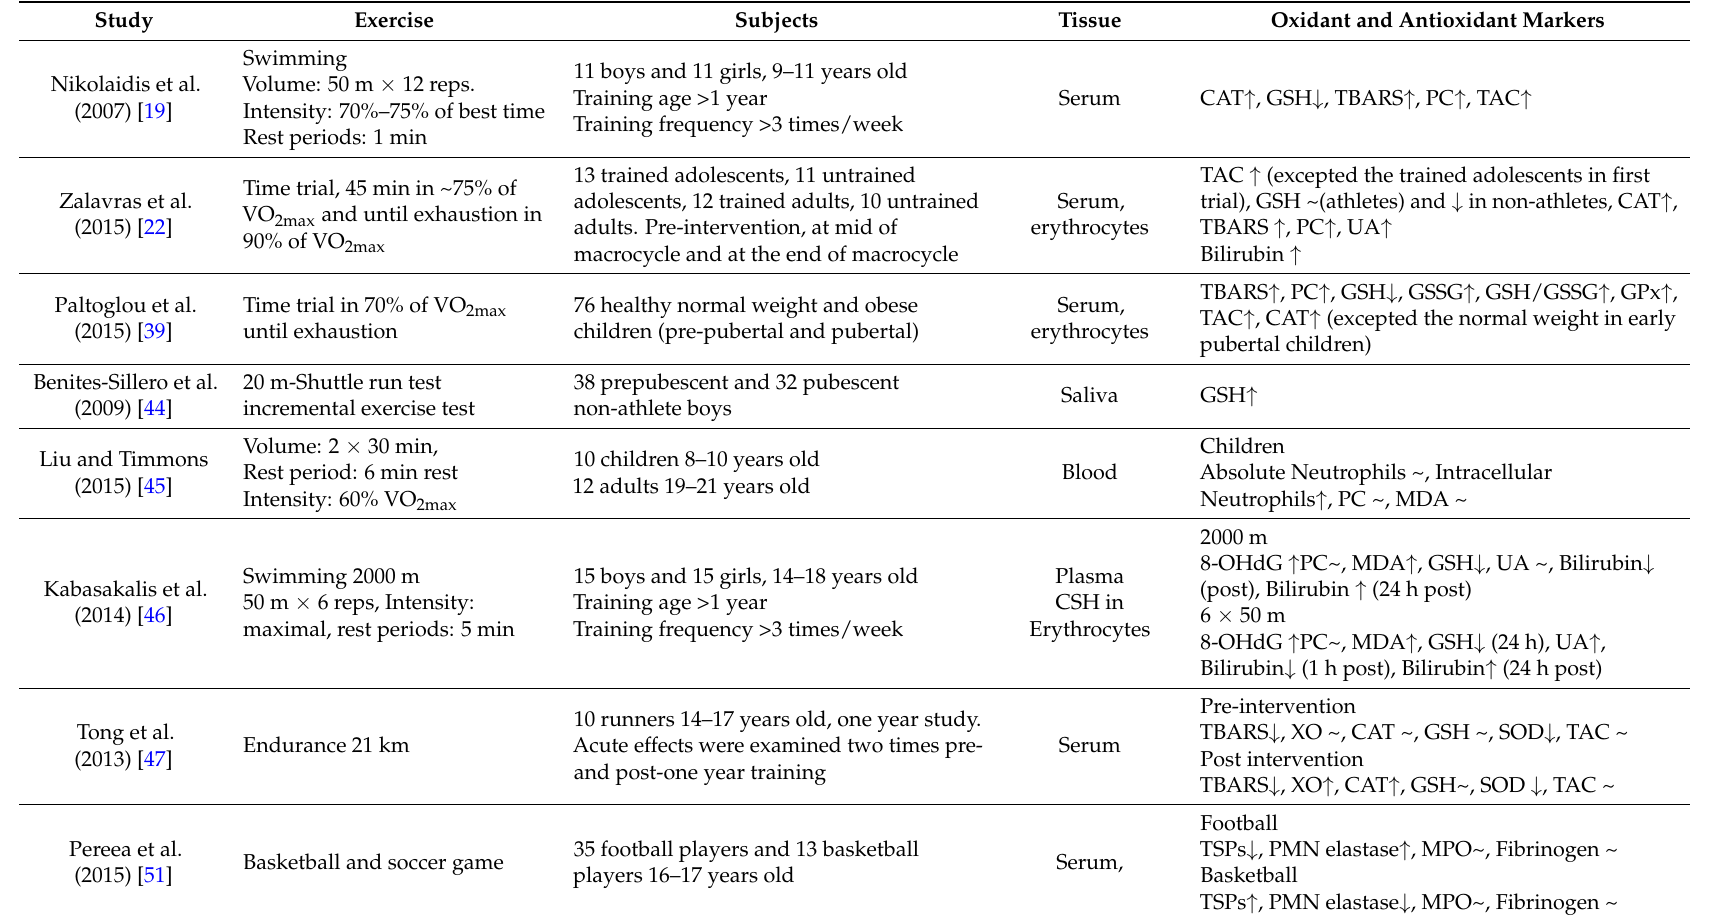
Table 1. Acute effects of exercise on oxidant and antioxidant